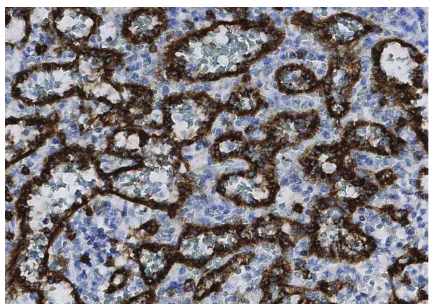
Figure 4: Photomicrograph × 20 magnification. The neoplastic cells express histiocytic antibody CD 68 as well as VIII whereas usual endothelial splenic cells only express